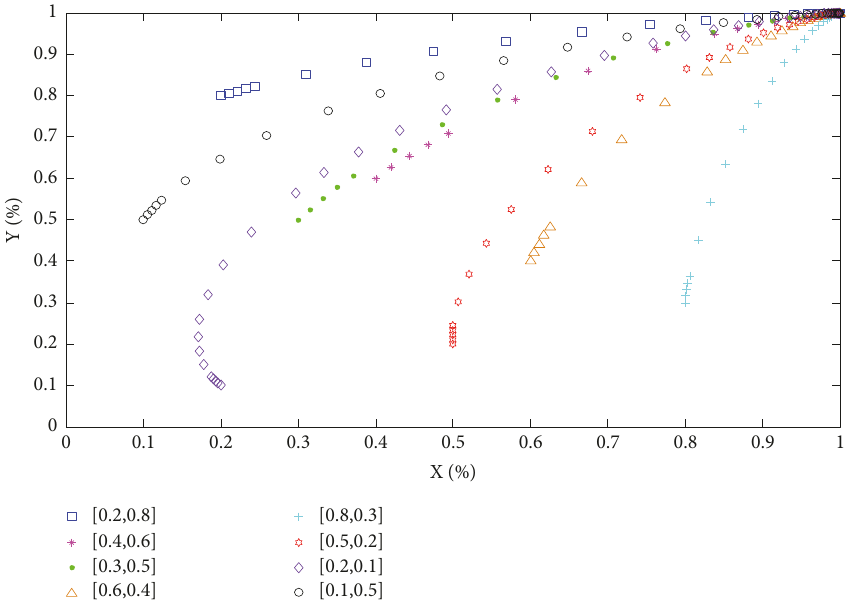
Figure 1: The Y-X type of phase diagram (ESS: